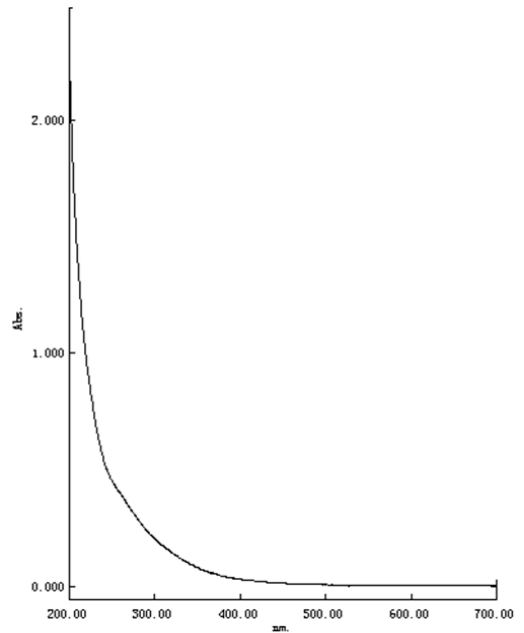
Figure 2. UV-vis spectrum of TPC-A aqueous solution (100 µg/mL) scanned in the wavelength range of 200–700 nm.